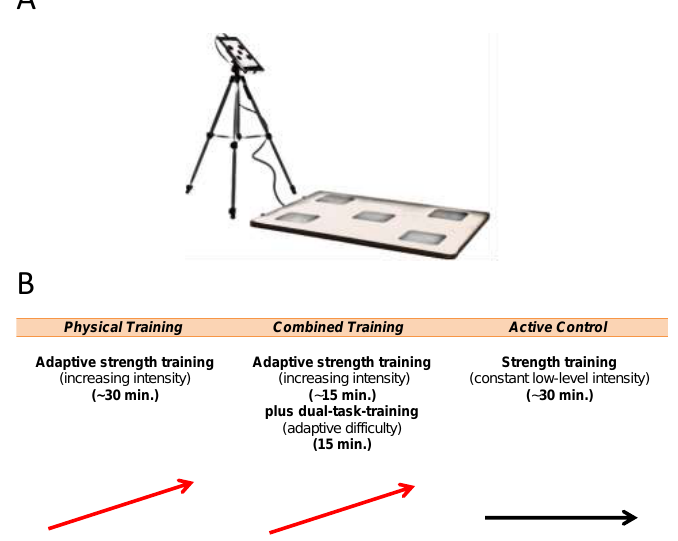
Figure 1. ( A ) Agility Board. This motor – cognitive training device consists of a tablet computer and a touch-sensitive response board. Users are presented with different cognitive tasks on the tablet and have to respond to these tasks by tapping or jumping on one or more of the 5 response fields on the board as quickly as possible. ( B ) Overview of the two training groups and the active control group. Adaptive strength training is symbolized by a red arrow, constant training by a black arrow.